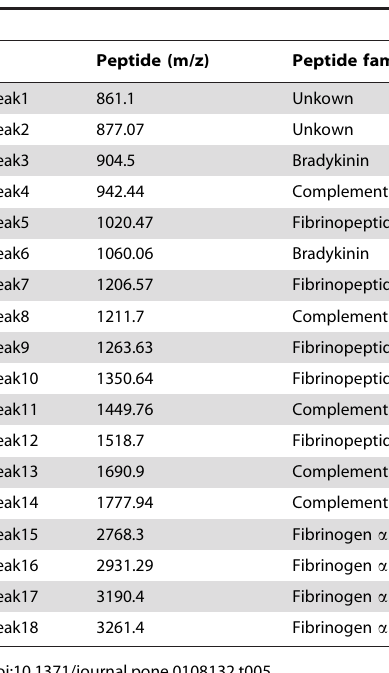
Table 5. Peptide family and amino acid sequences.